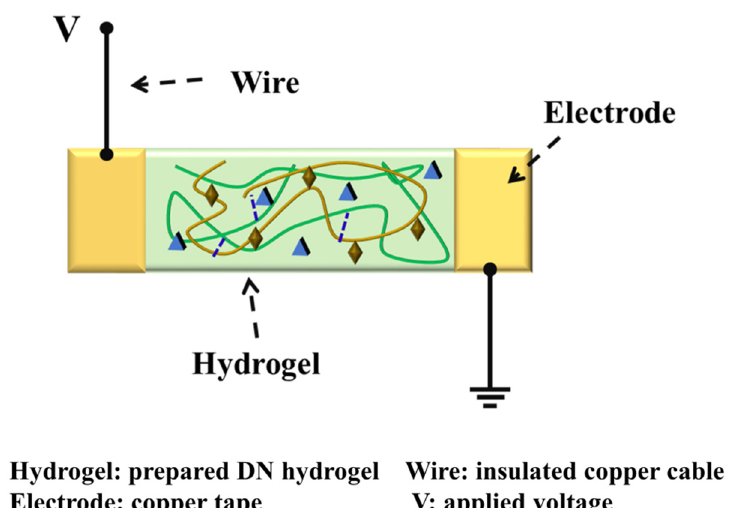
Figure 11. The schematic diagram of the strain sensor assembled using DN hydrogel and Cu elec- trodes.